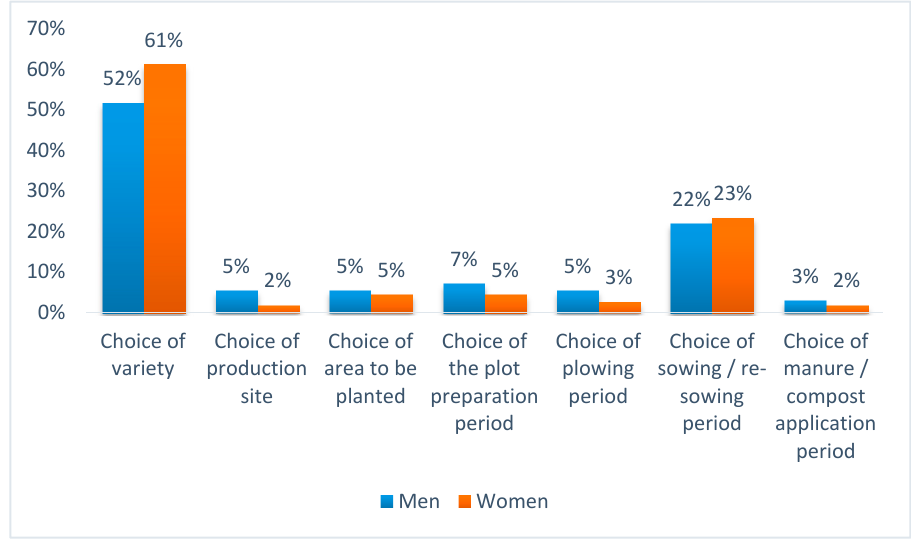
Figure 2. Decisions taken after the reception of seasonal forecast .